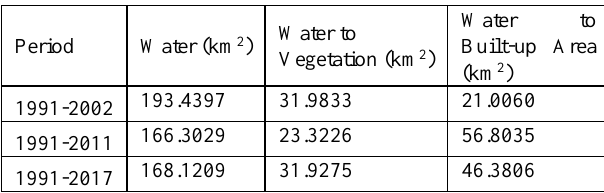
Table 4. The statistic of change detection results in different